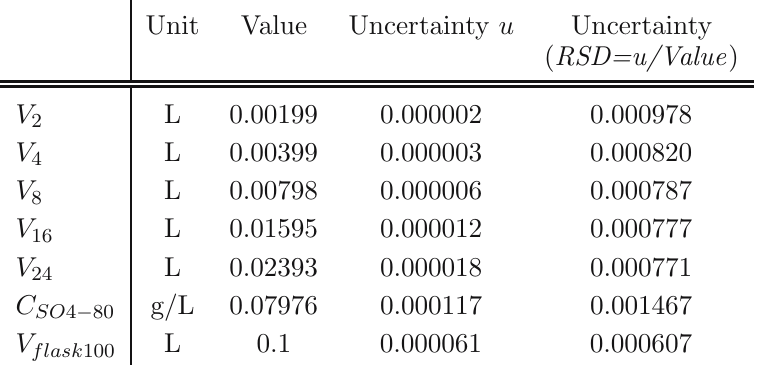
Table 4 Uncertainty components and their relative standard uncertainty of sulphate working